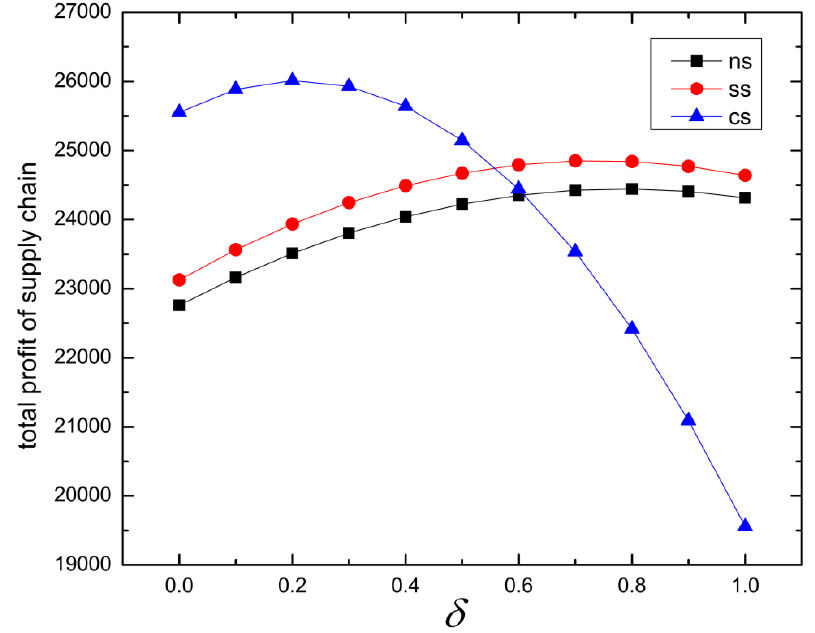
Figure 4. Total profit of the supply chain under different strategies.